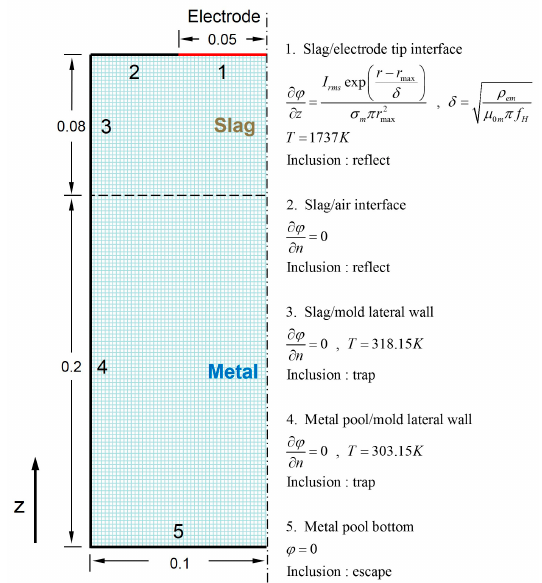
Figure 4. Boundary conditions. Table 1. Physical properties and operation